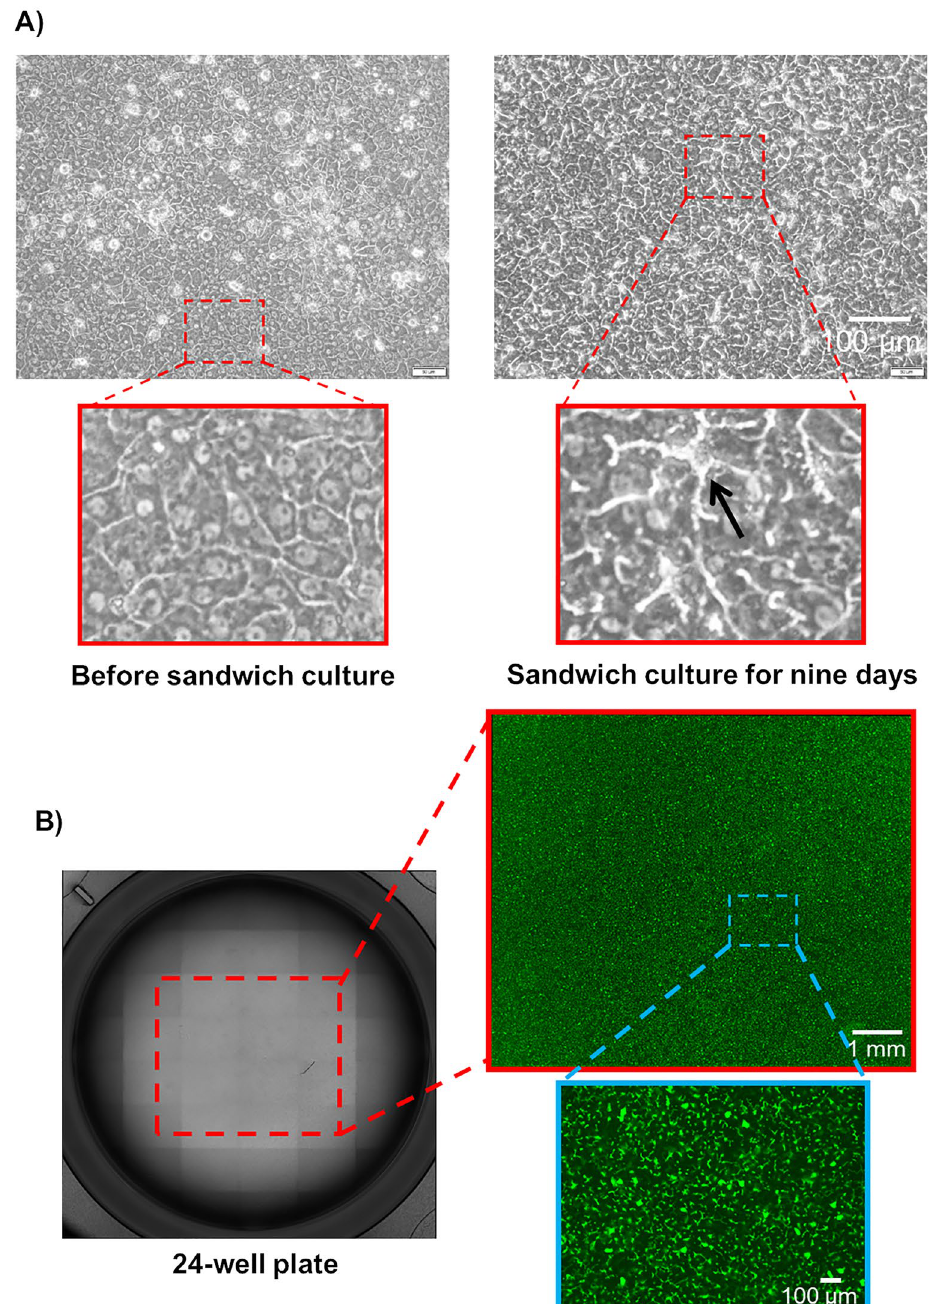
Figure 2. Bile canaliculi formed in suitable culture conditions. Human-induced pluripotent stem cell-derived hepatocytes were cultured in a long-term maintenance medium for 28 days and then, they were sandwich- cultured in a maintenance medium for 9 days. ( A ) The cell morphology that was observed using a phase- contrast microscope before and after the sandwich culture. The black arrow shows the extended bile canaliculi. After sandwich culture, the excretion of tauro-nor-THCA-24-DBD into a bile canaliculus was observed in a wide area within the well ( B : Red dotted line). Fluorescence images show ( B ) Tauro-nor-THCA-24-DBD, which was accumulated into bile